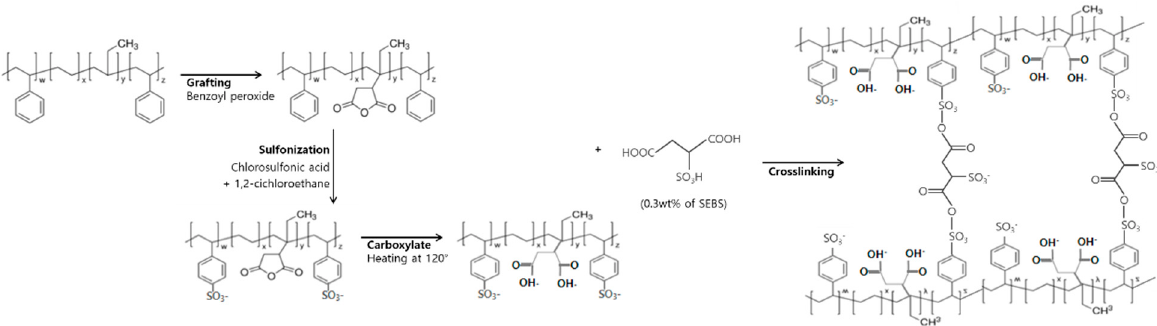
Figure 1. Scheme used for the preparation of MA-grafted SEBS based anion exchange membrane.